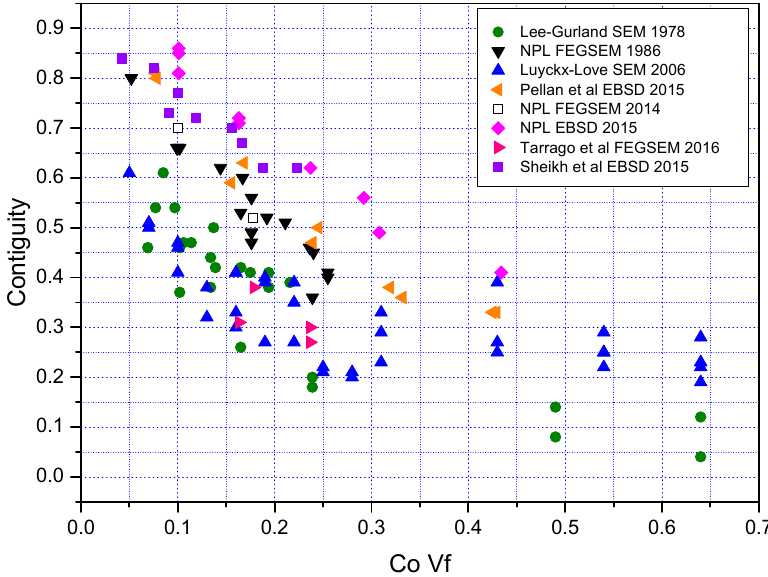
Figure 1. Contiguity measurements from the literature [1–6]. Note the wide range of results and higher electron backscatter diffraction (EBSD) contiguity measurements.